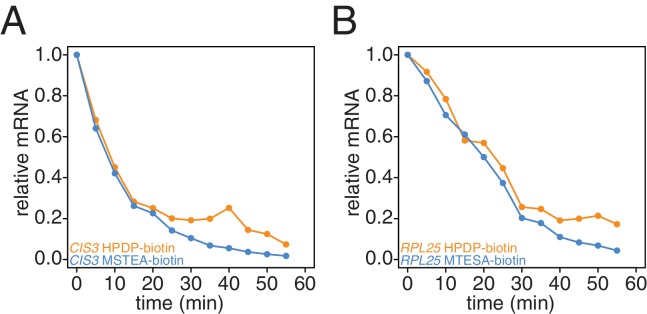
Comparison of HPDP-biotin with MTSEA-biotin in the efficiency of subtracting newly synthesized mRNAs during the chase phase.Wild-type cells (KWY165) were subjected to the 4TU-chase protocol and RNAs were biotinylated with either HPDP-biotin (orange) or MTSEA-biotin (blue). Levels of unlabeled CIS3 and RPL25 mRNAs were determined.